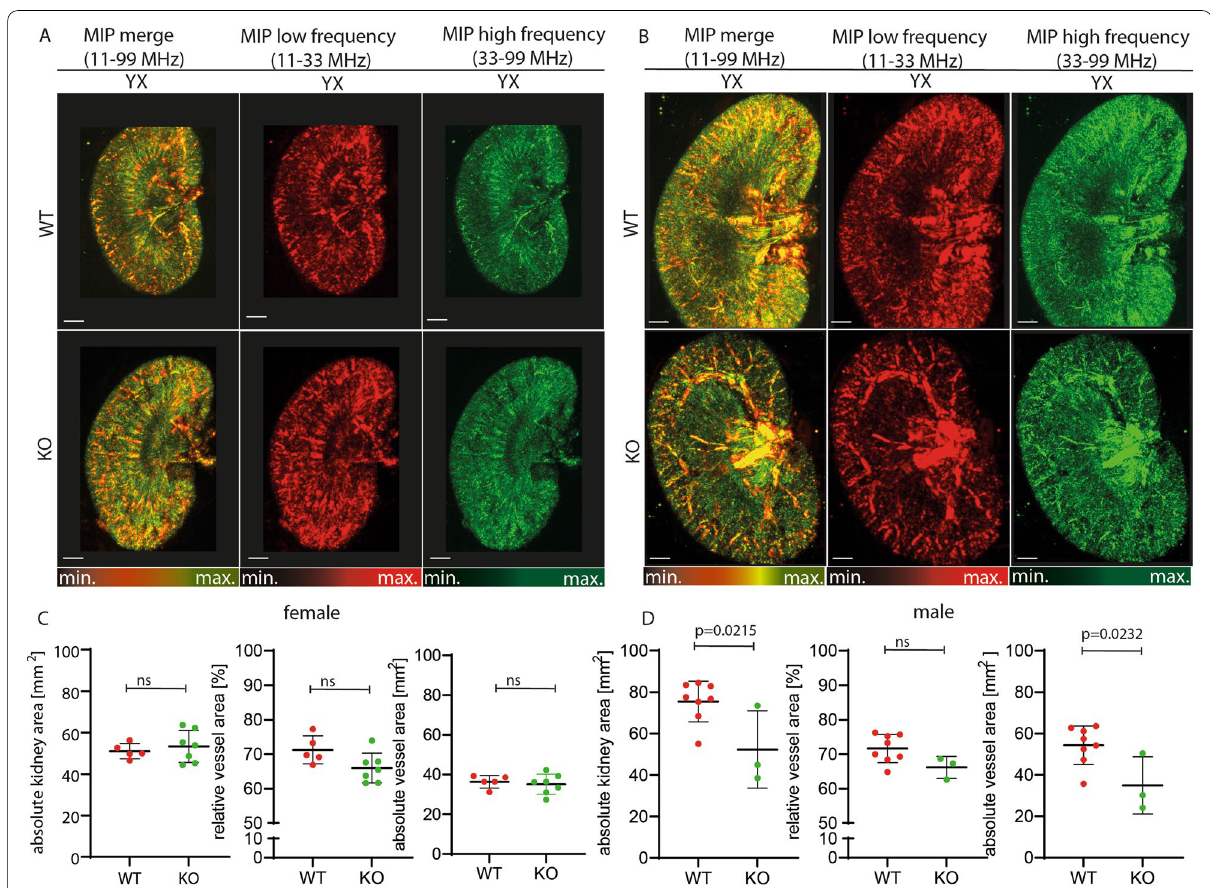
Fig. 3 Ex vivo RSOM images of healthy compared to KO mice. A , B Exemplary MIP images of female ( A ) and male ( B ) kidneys are shown. Top row WT genotype, bottom row KO genotype. Merged frequencies (big and small vessels, red-green), low frequencies (bigger vessels red), and higher = frequencies (smaller vessels green) are shown. Scale Bars 1mm. C , D WT and KO female ( C ) and male ( D ) kidneys were compared for absolute = kidney area in mm 2 , relative vessel area, and absolute vessel area in mm 2 derived from merged images. Bars and whiskers mark mean SD. A p ± value <0.05 indicates statistical significance. ns not significant, MIP maximum intensity projection. LF low frequencies, HF high frequencies, = = = = MF merged frequencies, WT wildtype genotype, KO knock-out genotype, min. minimum, max. = = = = =